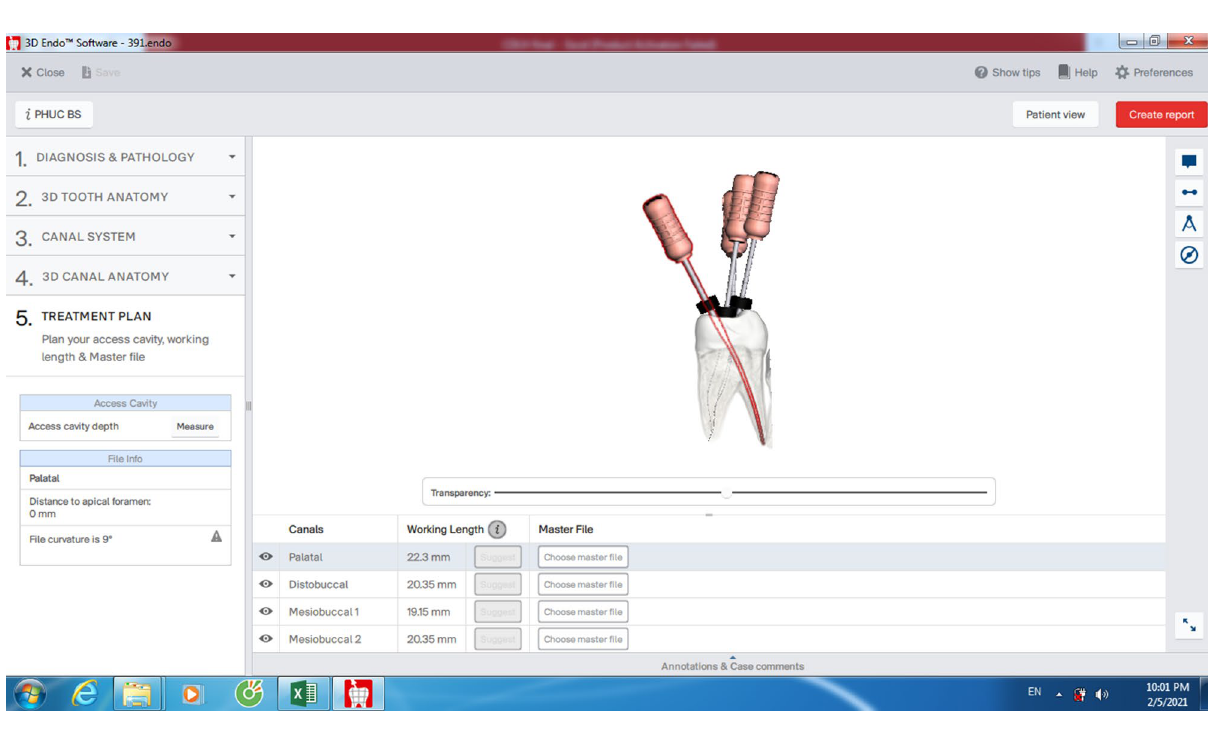
Figure 4. Corrected length measurement on the 3D Endo